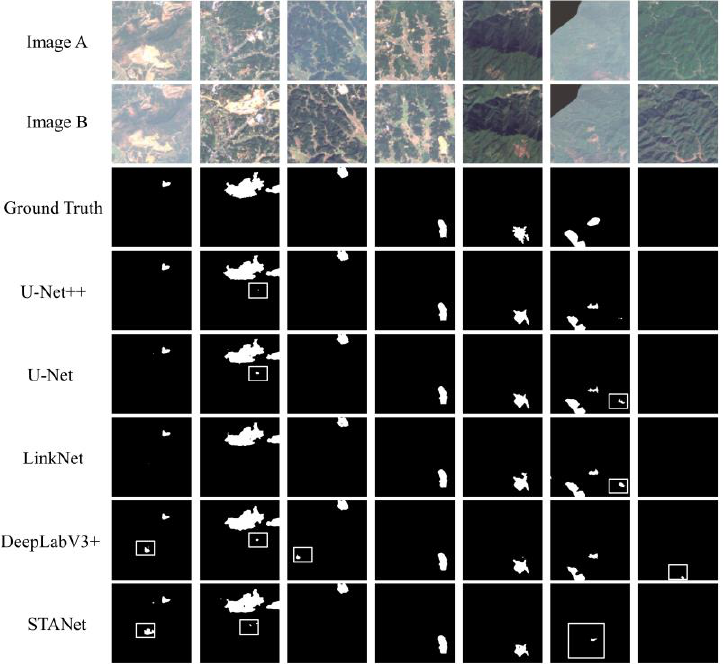
Figure 9. Comparison of the spatial mapping results for each model; 1–6 columns are for image pairs containing forest changes, and the last column is for image pairs with no changes.